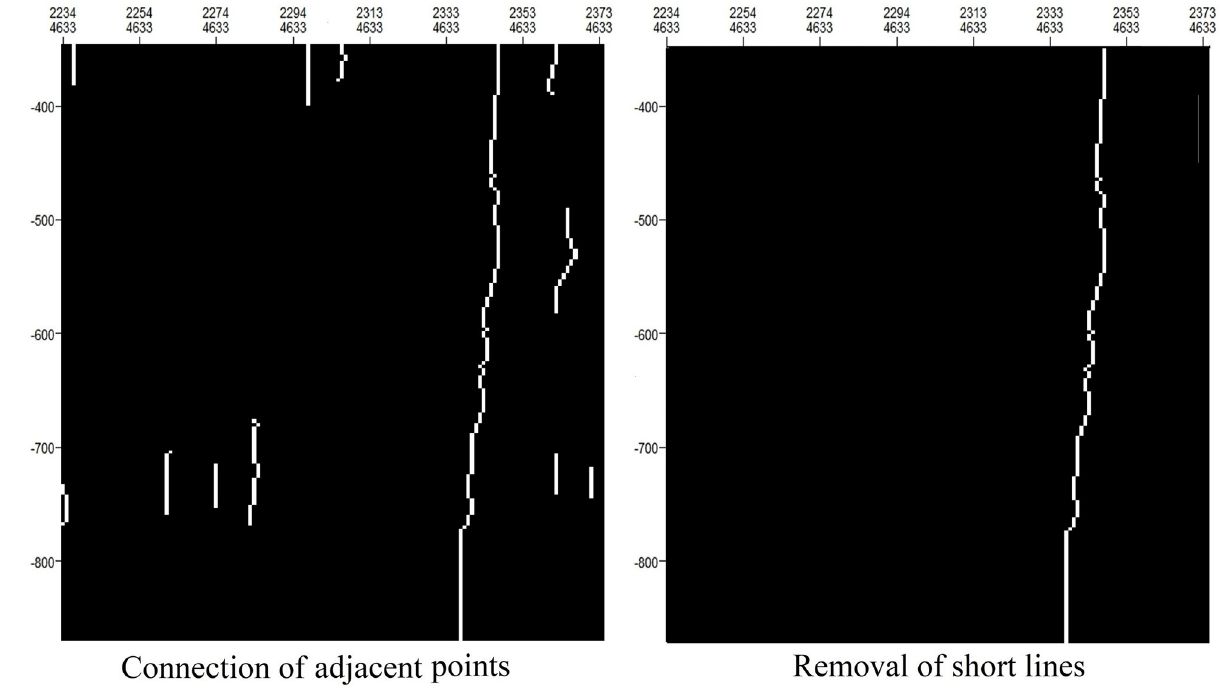
Fig 7. Removal of short